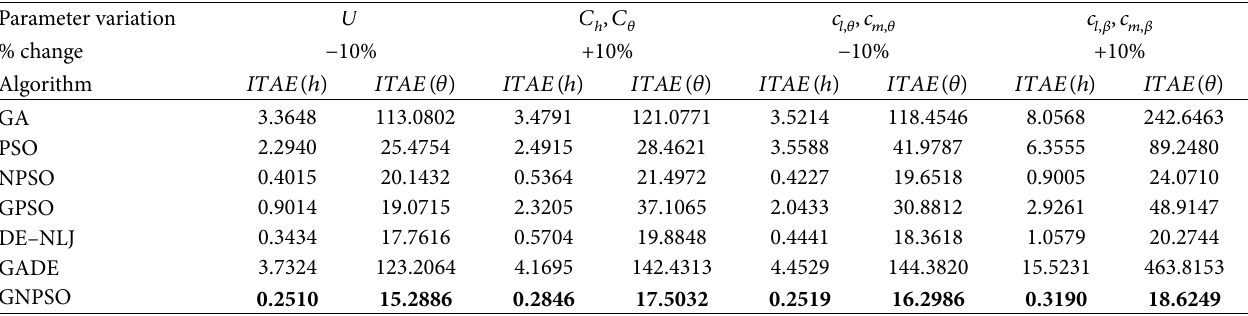
Table 17: Robust performance of GA, PSO, NPSO, GPSO, DE–NLJ, GADE, and GNPSO for MIMO nonlinear wing vibration control system.